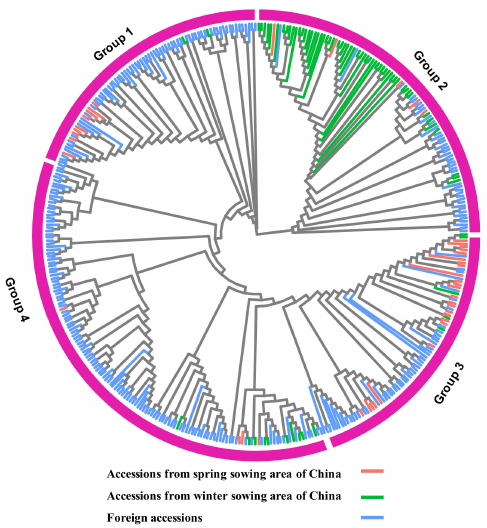
Figure 2. Cluster analysis of 410 faba bean accessions based on the NJ